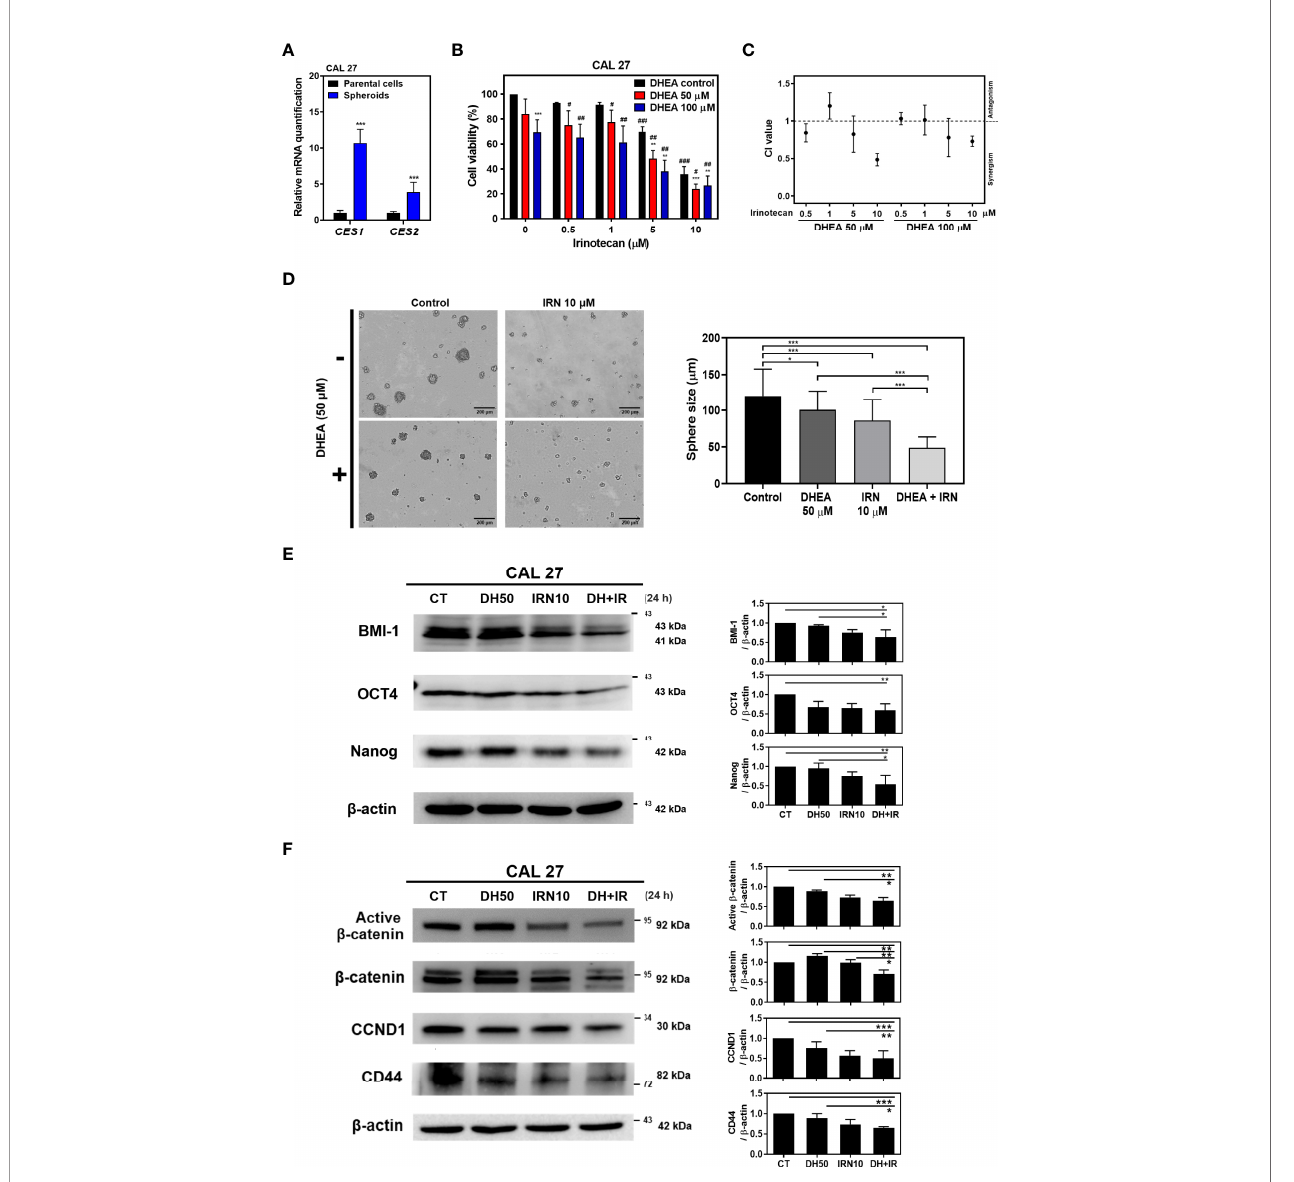
FIGURE 3 | DHEA combinated with IRN synergistically decreased cell viability and stemness, and further downregulated WNT pathway in CAL 27. (A) RT-qPCR results showing mRNA level of IRN-metabolism enzymes in CAL 27 spheroids and parental cells. CES1/2 : carboxylesterase 1/2. (B) CAL 27 cells were treated with DHEA (0, 50, and 100 m M), IRN (0, 0.5, 1, 5, and 10 m M) alone or in combination for 72 h and cell viability was determined by SRB assay. Data represent mean ± SD derived from three independent experiments. * p < 0.05; ** p < 0.01; *** p < 0.001, compared to the same concentration of DHEA using t-test . # p < 0.05; ## p < 0.01; ### p < 0.001, compared to the same concentration of IRN using t-test. (C) CI following various treatments in (B) . CI > 1, antagonism; CI = 1, additivity; CI < 1, synergism. (D) Sphere formation assay showing CAL 27 cells co-incubated with DHEA (50 m M) and/or IRN (10 m M). Scale bar: 200 µm (E, F) Western blotting showing protein expression of stemness markers (E) , and WNT pathway-related factors (F) in the whole cell lysate extracted from CAL 27 after DHEA and/or IRN treatment for 24 h Left , representative western blots of three independent experiments are shown. Right , bar charts represent the quantitation of three independent experiments. Data represent mean ± SD derived from three independent experiments. * p < 0.05; ** p < 0.01; *** p < 0.001 using t-test . All treatments were maintained in the same percentage of DMSO. CT, control; DH, DHEA; IRN,